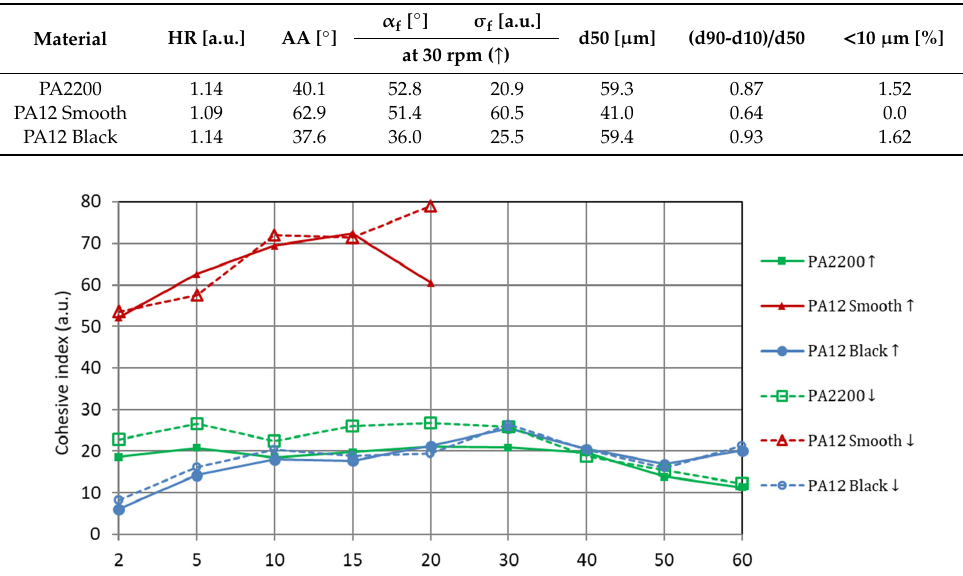
Figure 3. Cohesive index curves recorded as a function of the increasing ( ↑ ) and decreasing ( ↓ ) rotation speed for polyamide powders.